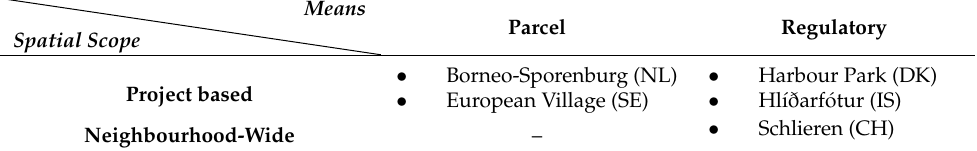
Table 2. Preliminary categorisation of regulatory strategies to regulate façade lengths. Source: authors. Spatial